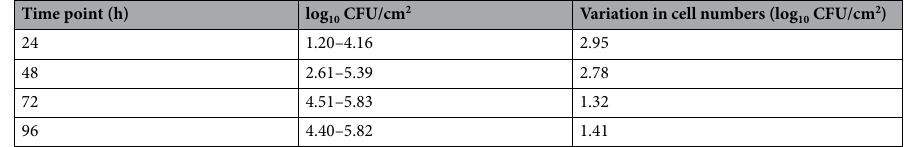
Table 1. Mean biofilm density (log 10 CFU/cm 2 ) range of all 52 L. monocytogenes biofilm isolates at sampled